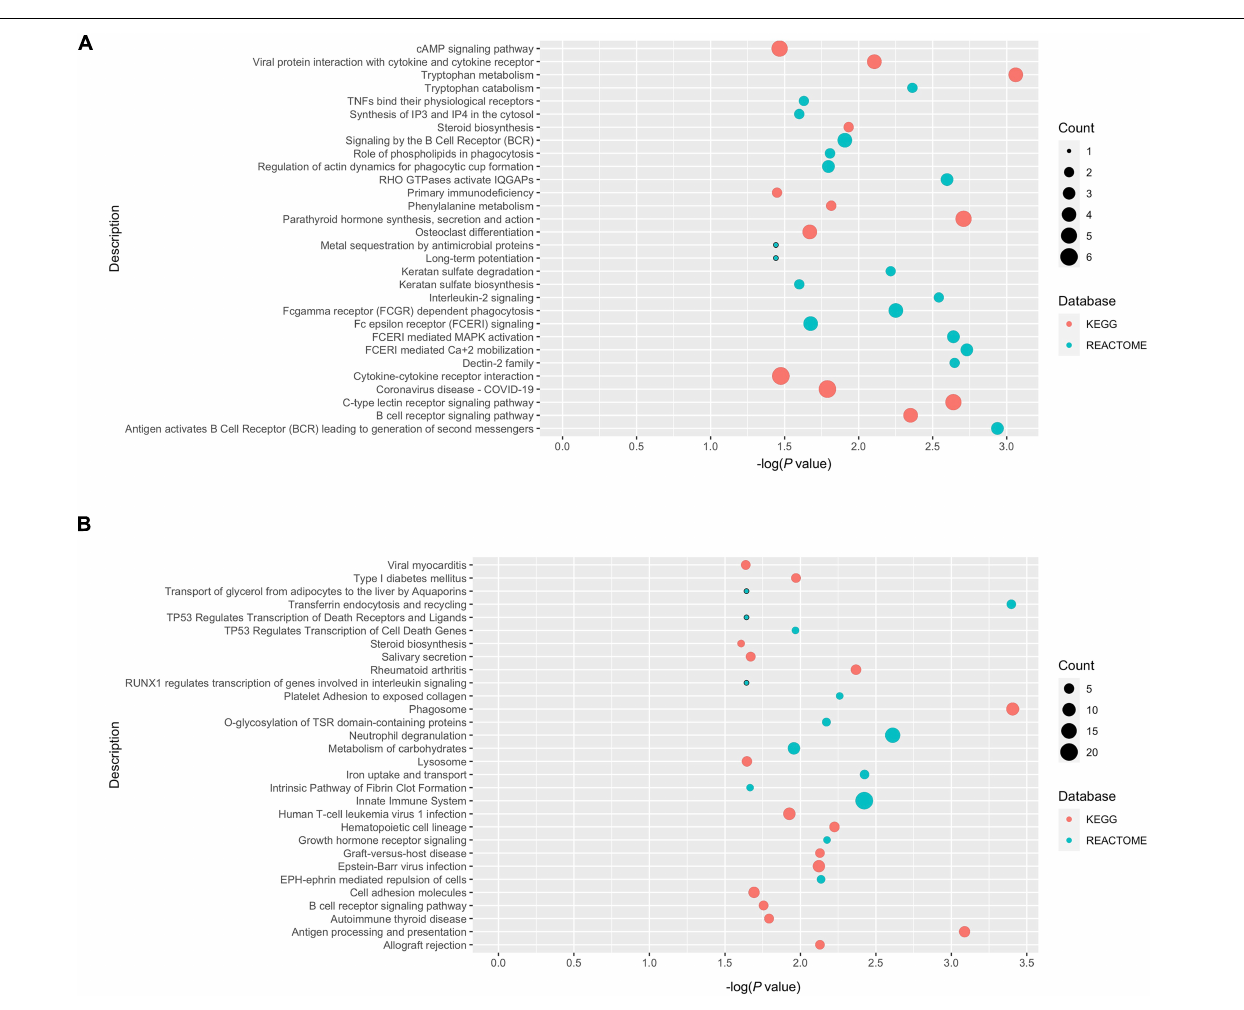
FIGURE 5 | Over-presentation analysis of class 1 and class 2 genes in the POCD and AD hippocampus. (A) Class 1 genes (dysregulated in the same direction in POCD and AD); (B) class 2 genes (dysregulated in different